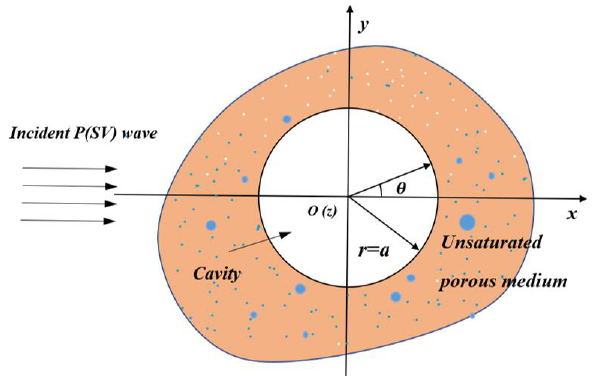
Figure 1. Cylindrical cavity in unsaturated medium.